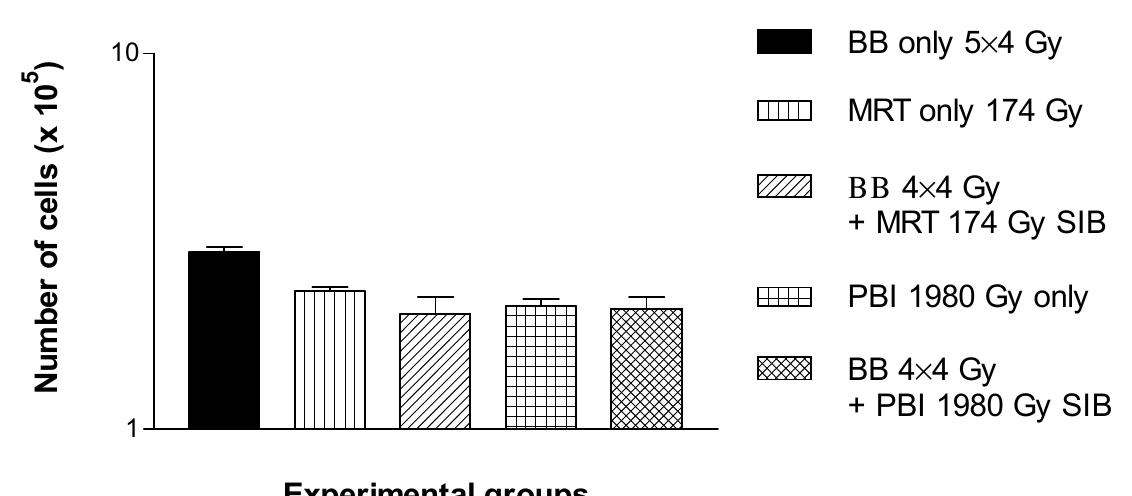
Figure 4. Cell counts after the late microbeam SIB. A significantly increased cell destruction, compared to the non-irradiated controls, was seen in all irradiated groups. The differences in the cell destruction were also statistically significant between the low dose rate and the high dose rate irradiation groups but not between the two high dose rate irradiation groups.